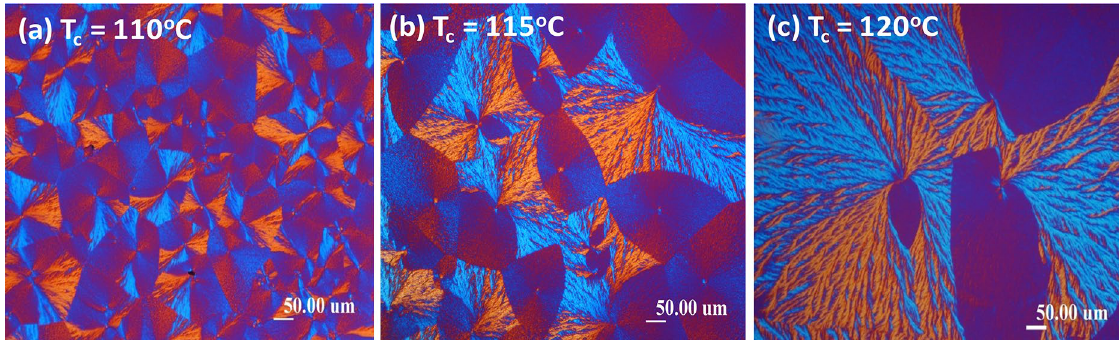
Figure 3. POM images of PLLA/PMMA (80/20) samples of a fixed film thicknesses ≈ 10 μm, melt-crystallized at various